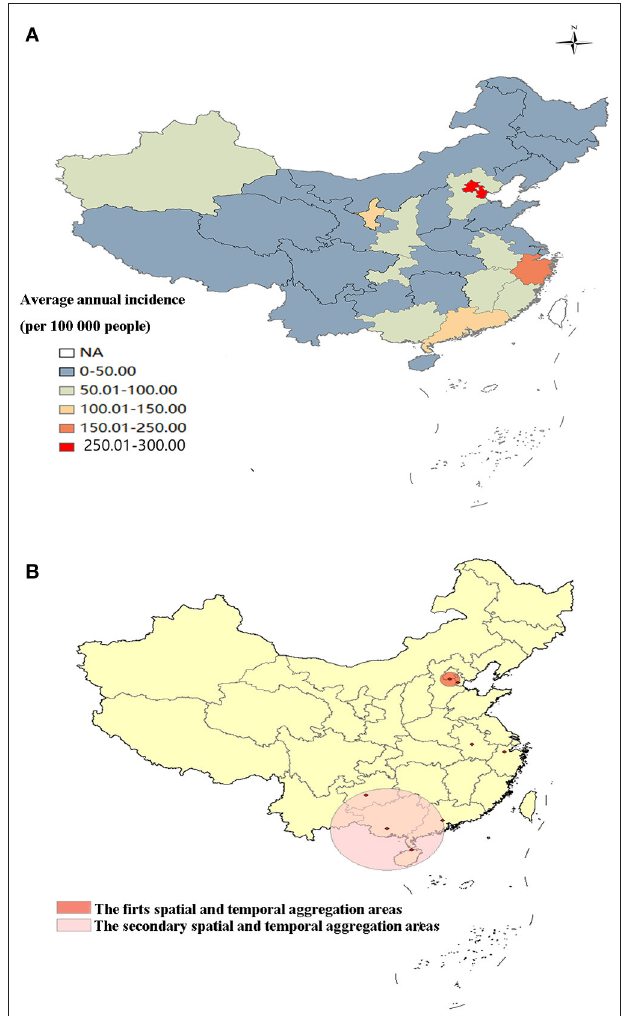
FIGURE 4 | Spatial and temporal aggregation of other infectious diarrhea. (A) Geographical distribution of OID in mainland China. (B) Spatial and temporal aggregation of OID from 2004 to